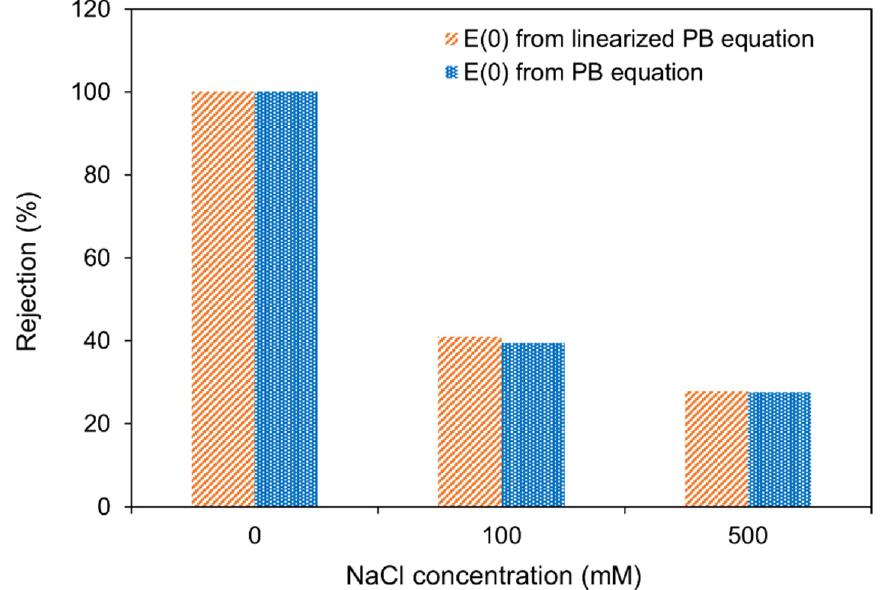
Figure 2. Comparison of rejection predictions for poly (dT 60 ) ssDNA made using the non-linear PB equation (solution of Equation (3)) to predictions made using the solution of the linearized PB equa- tion (Equation (5)) to describe electrostatic DNA–membrane interactions for a 30 nm pore mem- brane. Hydrodynamic interactions were neglected in these calculations (i.e., 𝐺 = 1 ).